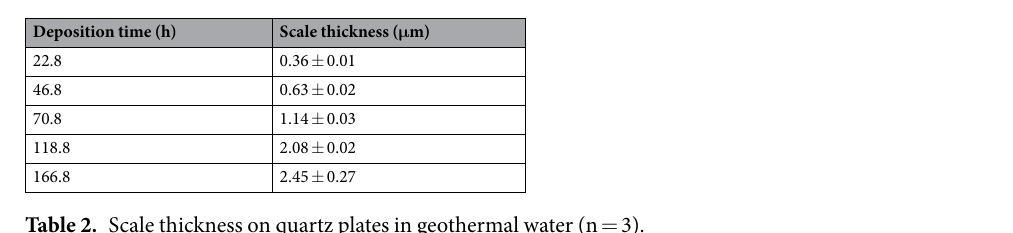
Table 2. Scale thickness on quartz plates in geothermal water (n =